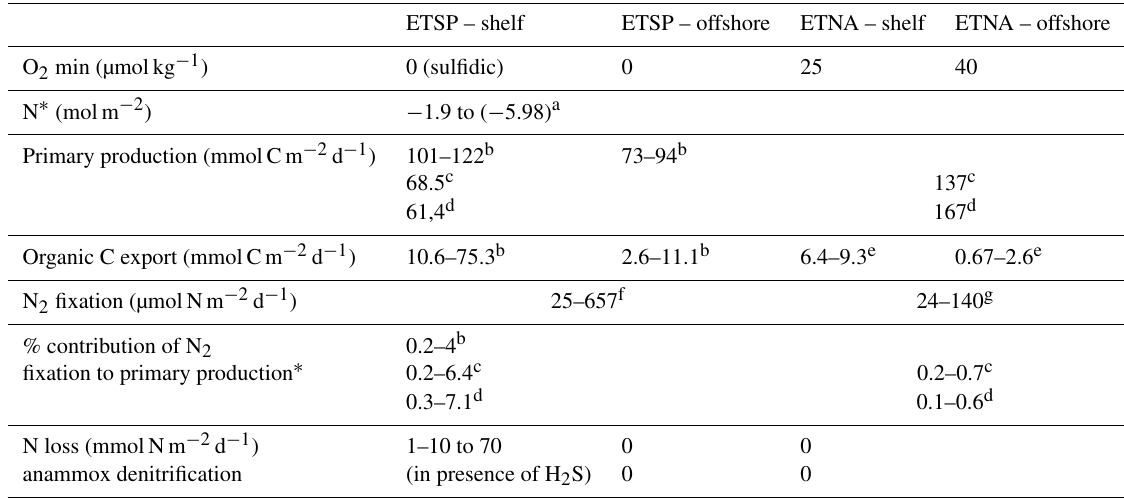
Table 1. A comparison of the O 2 minimum, excess nitrogen (N*), primary production, organic C export, N 2 fixation and N loss in the ETNA and ETSP upwelling